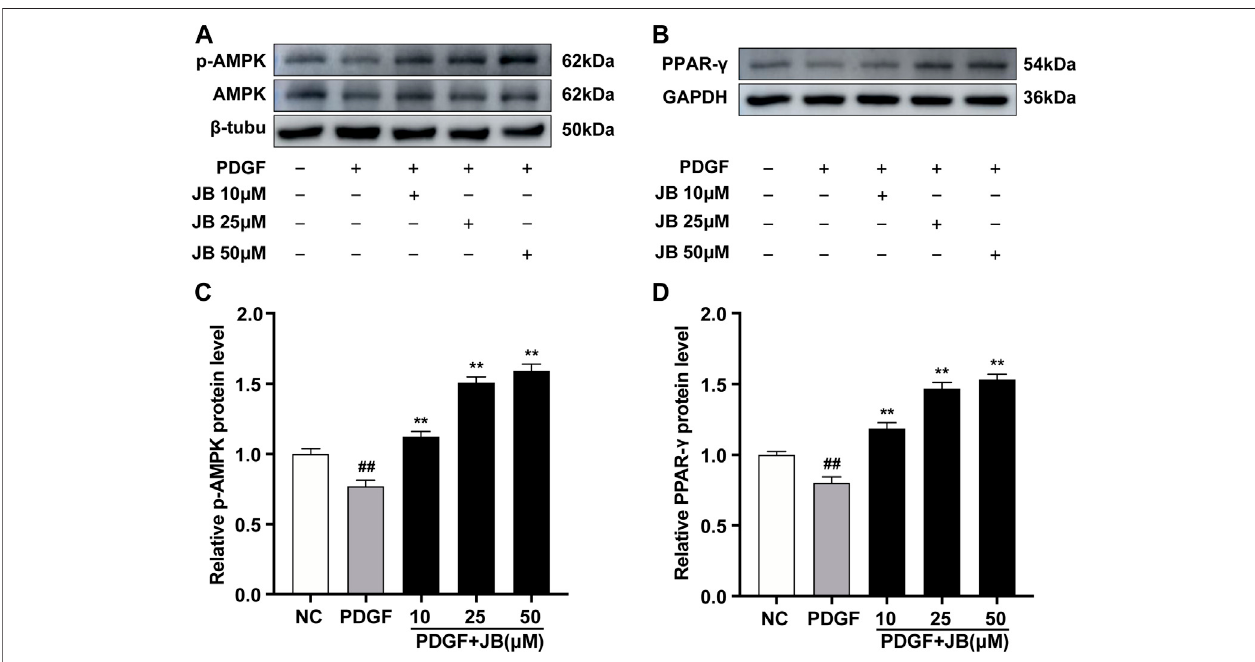
FIGURE 7 | JB activated AMPK/PPAR- γ pathway in VSMCs. VSMCs were incubated with PDGF-BB in the presence of different concentrations of JB. (A,B) Western blotting analysis of p-AMPK, AMPK (A) , PPAR- γ (B) in VSMCs. (C,D) Quanti fi cation of p-AMPK, AMPK (C) , PPAR- γ (D) protein expression levels between groups. Data are expressed as mean ± S.D. ## p < 0.01 vs. Control. ** p < 0.01 vs. PDGF-BB group. n (cid:1)